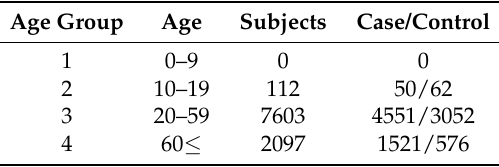
Table 1. Developed age groups where subjects were